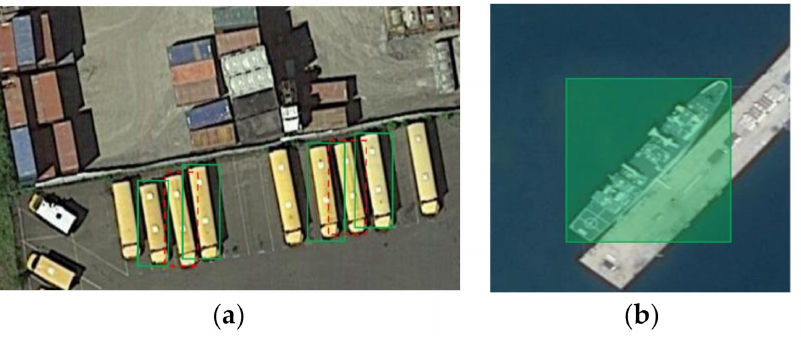
Figure 1. ( a ) Horizontal detection boxes may lead to missed detections (red boxes) and ( b ) introduce unwanted ambient pixels.